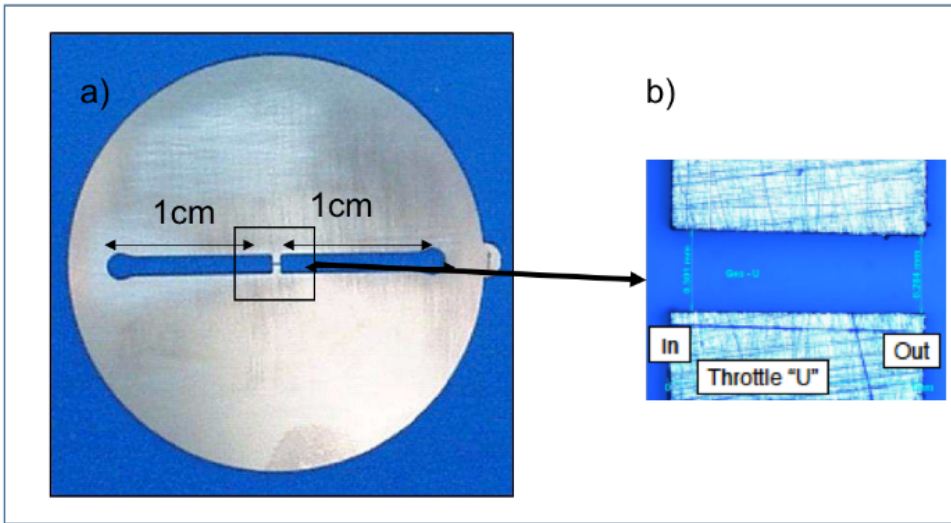
Figure 1. ( a ) View of the experimental nozzle ( b ) Enlarged view of throttle geometry U.